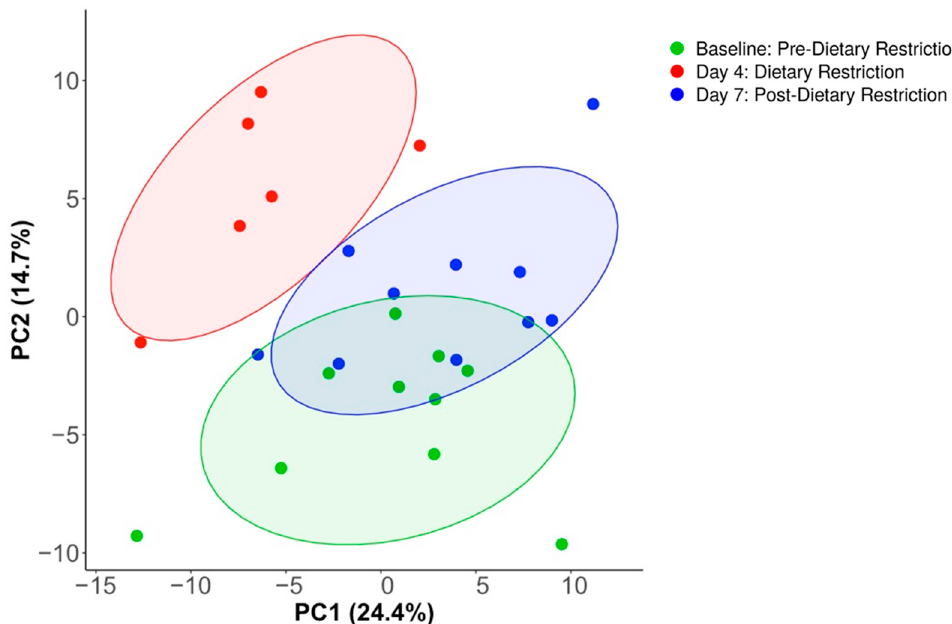
Figure 7. Principal component analysis of MetaCyc pathway abundance after prevalence filtering. Similar to the findings of taxonomy analysis, dietary restriction created unique clustering on Day-4, while Baseline and Day-7 conditions showed overlap clustering, representing group similarities.